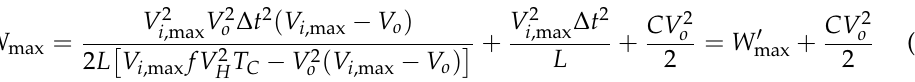
Figure 2. Output short test circuit of the Buck converter. From Figure 2, G is the safety spark test device. When the two electrodes of G contact, the output is short-circuited.